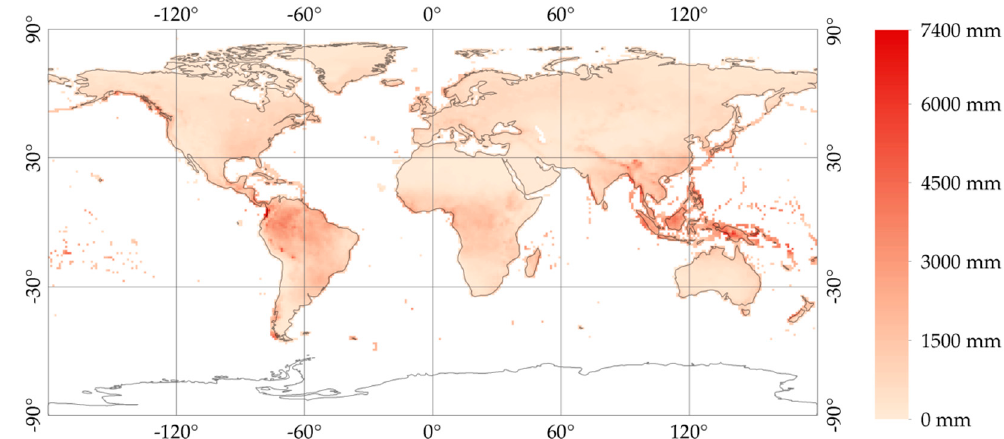
Figure A2. The mean annual rainfall calculated using 10 years of GPCC monthly “Monitoring product”. The white areas are places characterized by an absence of measurement. The reference system is WGS84.